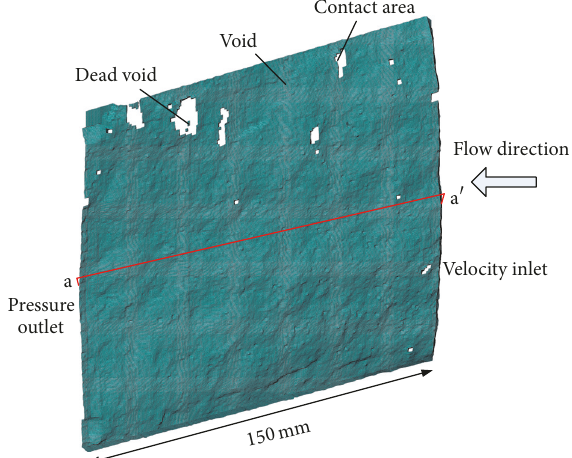
Figure 3: Gr3 model with void space geometry and contact area